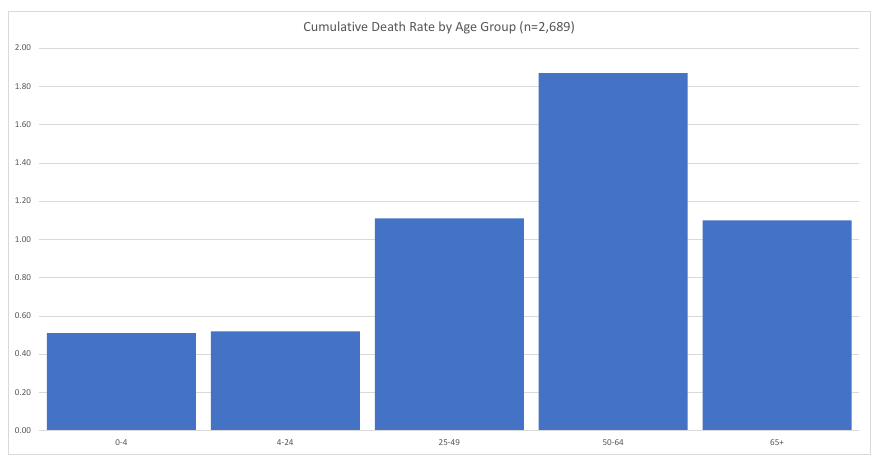
Figure 10. Flawed data led to a massive overestimation of the fatality rate of H1N1. Eleven years later, data collection is still a challenge. Source: